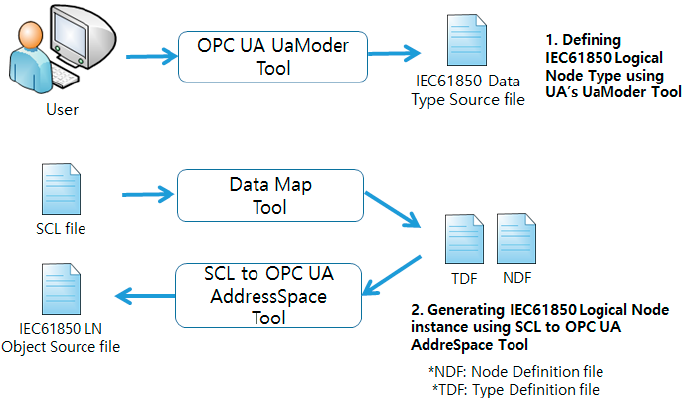
Figure 5. The whole design flow.